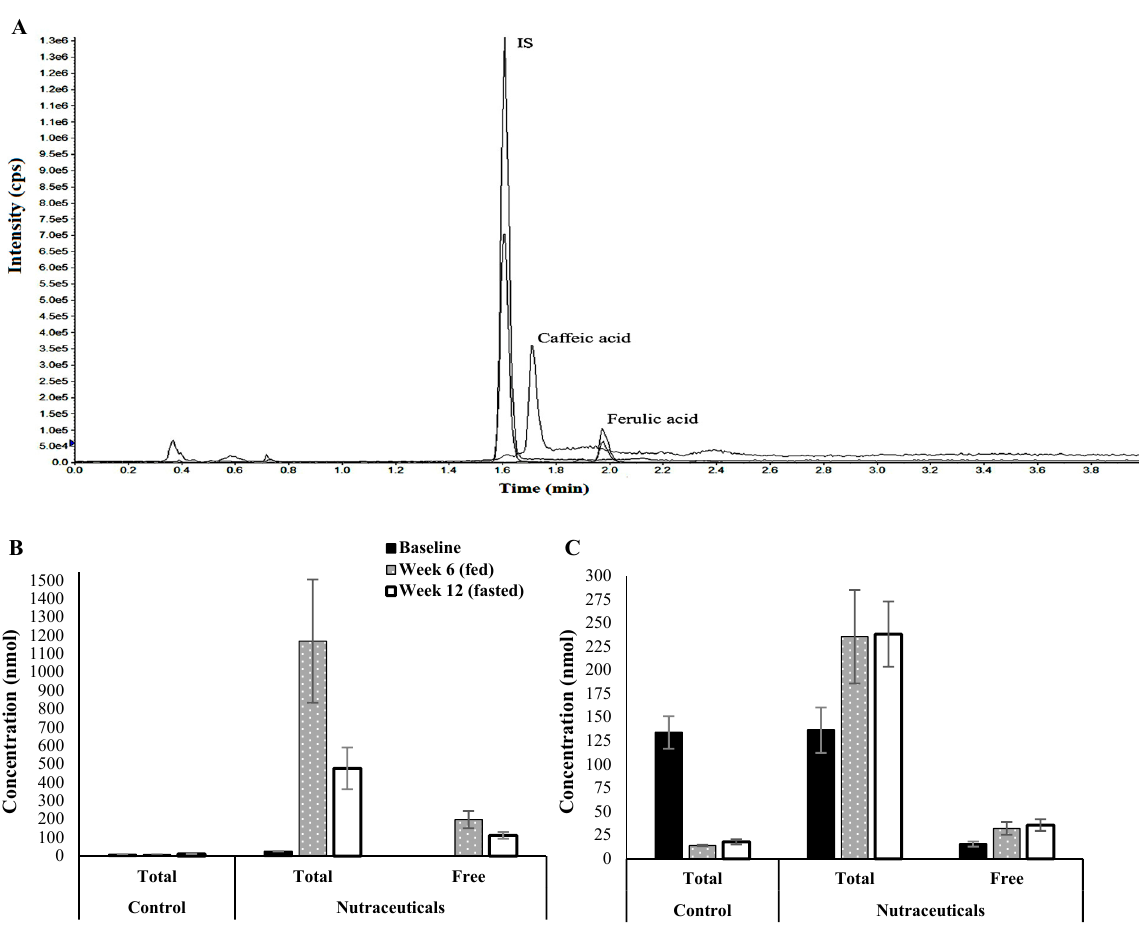
Figure 5. Quantitative HPLC-MS/MS data: ( A ) extracted ion chromatograms of caffeic acid, ferulic acid and internal standard in plasma; ( B ) plasma levels of total and free caffeic acid and ( C ) ferulic acid at different time points in both study groups calculated by an external standard calibration method. Error bars represent ± standard error of the mean.